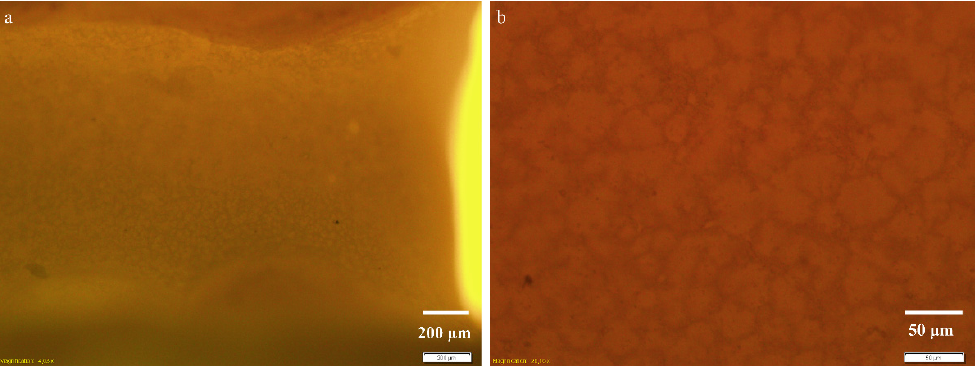
Figure 6. Optical images recorded in biofilm, on the PPE side of the main channel, at increasing magnifications of ( a ) 4.032×, in bright-field, and ( b ) 20.16×, in DIC, respectively.